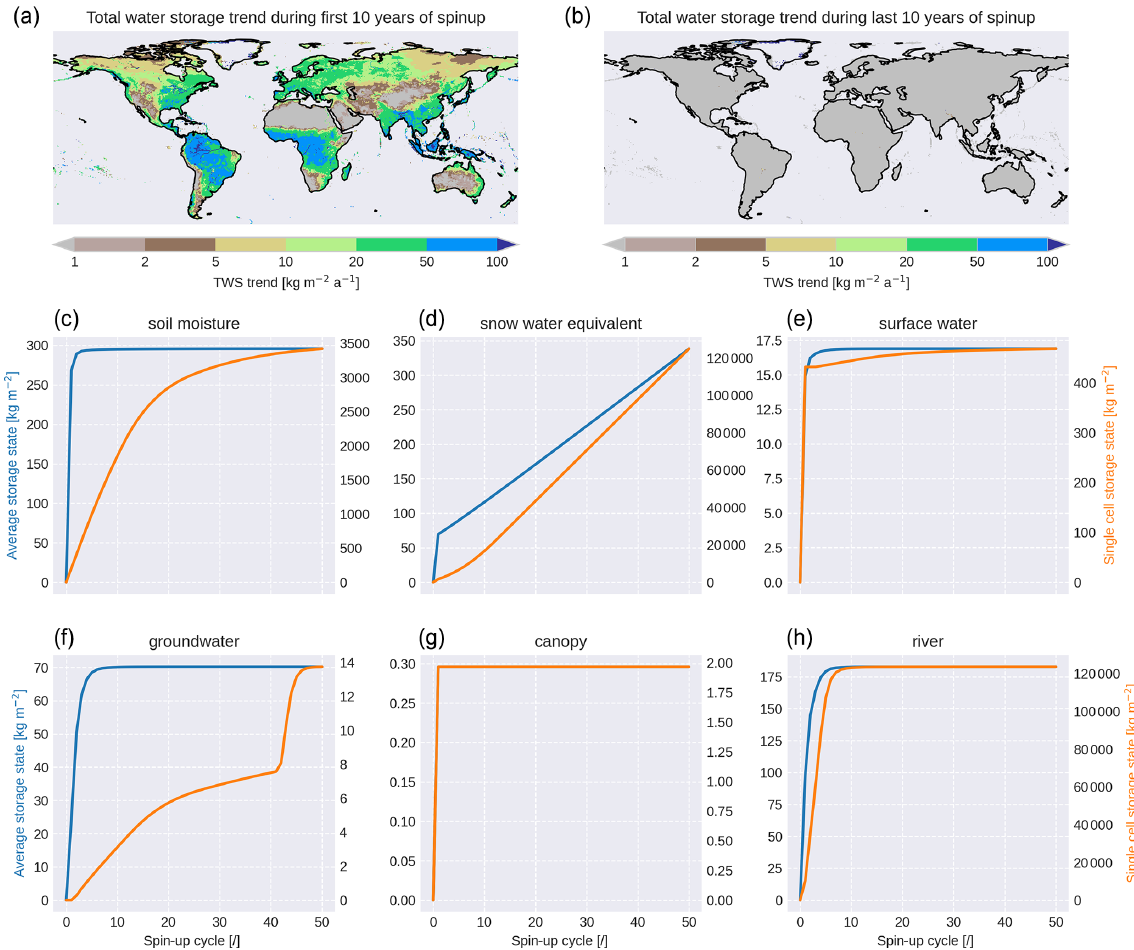
Figure 5. Evolution of various storage contents during HydroPy spin-up. The maps shows the trends in the total water storage (all storage accumulated) during the first (left map) and last (right map) 10 years of spin-up. Blue lines show values averaged over the whole land surface, and orange lines represent the grid cell with the largest residual trend at the end of the spin-up